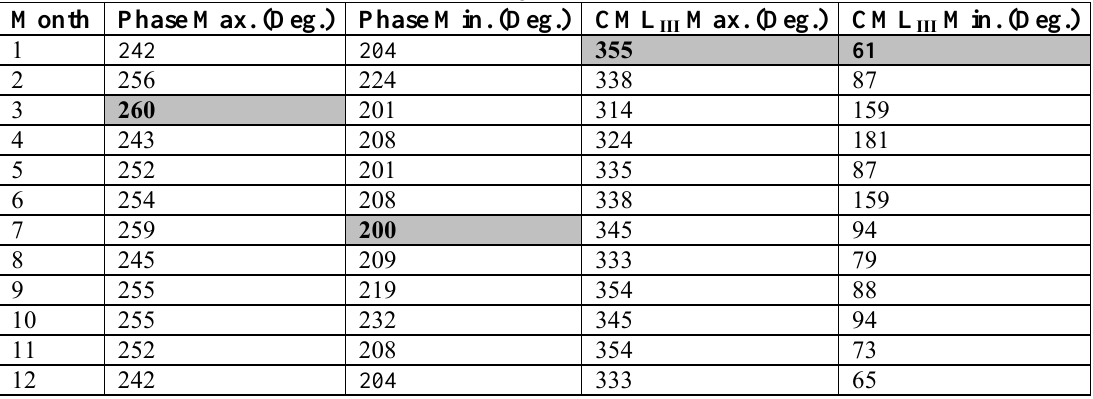
Table3: Io-C for year (2006).